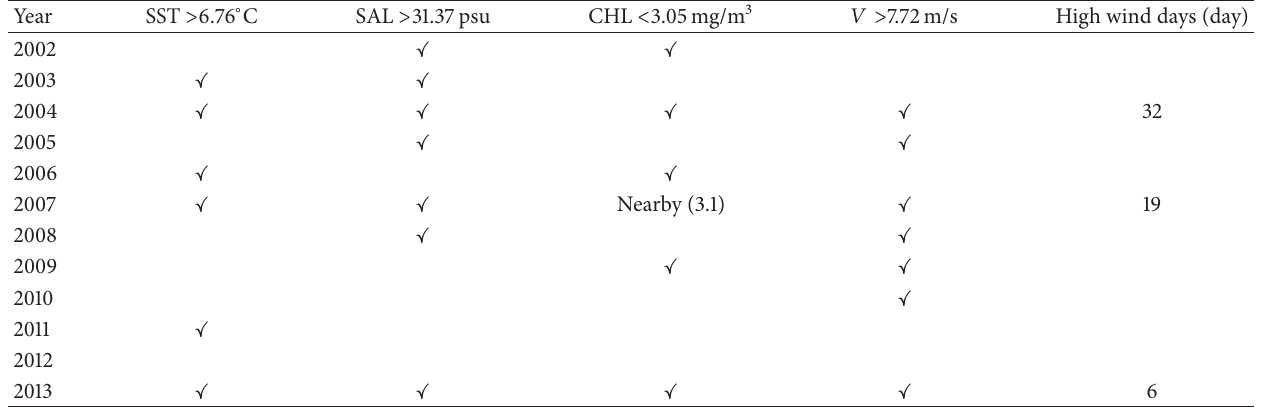
Table 4: Analysis of characteristics of the movement of the YSWC into the Bohai